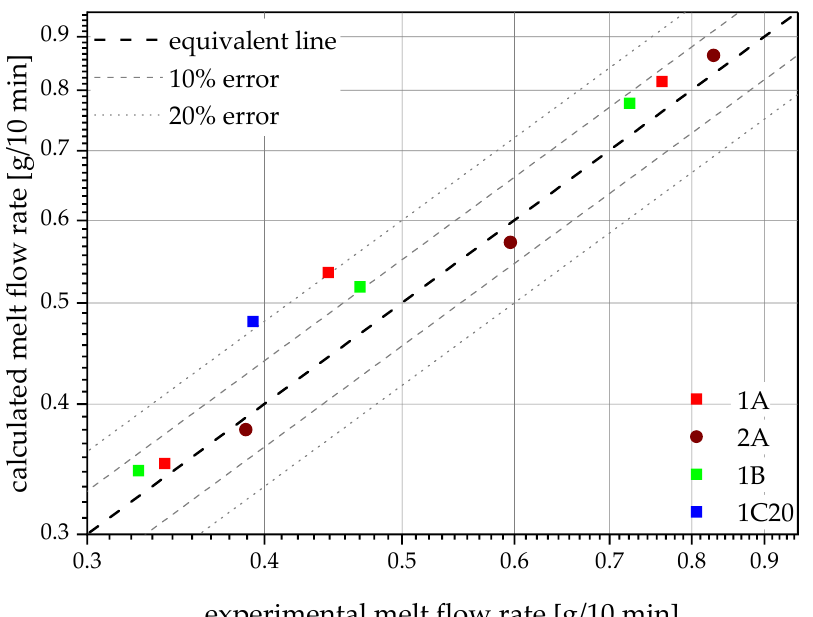
Figure 2. Plot of calculated (via Arrhenius mixing rule) vs. experimental MFR values. Most compounds lie within or around the 10% error range. Only 1A20 (0.54 g/10 min calculated vs. 0.44 g/10 min experimental MFR) and 1C20 (0.48 g/10 min calculated vs. 0.39 g/10 min measured MFR) show around 20% error.